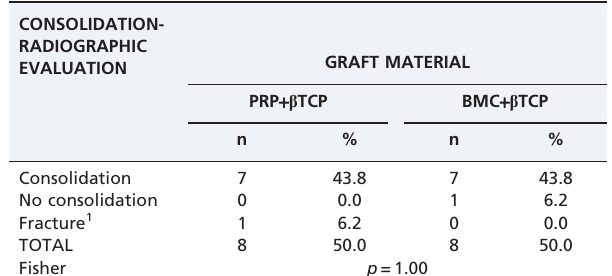
Table 1 - Measurements of the consolidation of defects filled with PRP + b TCP and BMC + b TCP using radiographic evaluation. Comparison by Fisher’s exact test ( a = 0.05 bilateral).